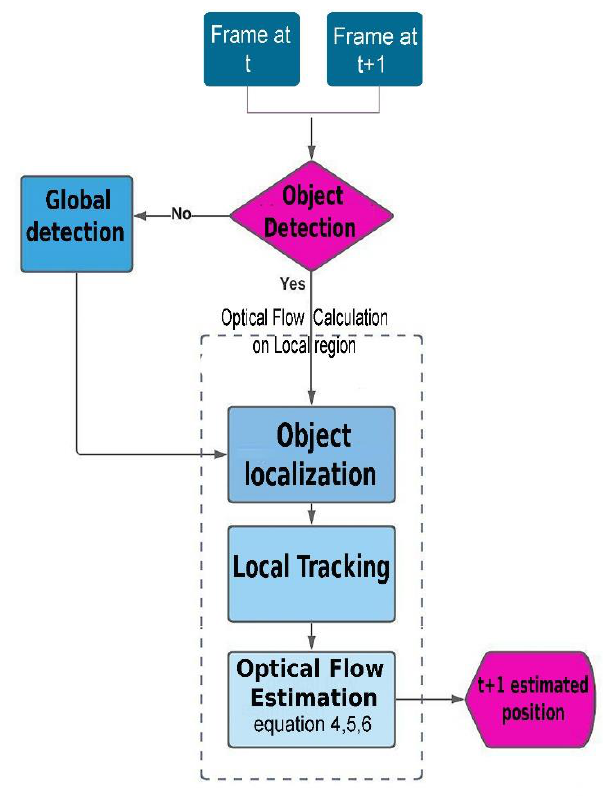
Figure 2. Algorithm diagram of the proposed method.